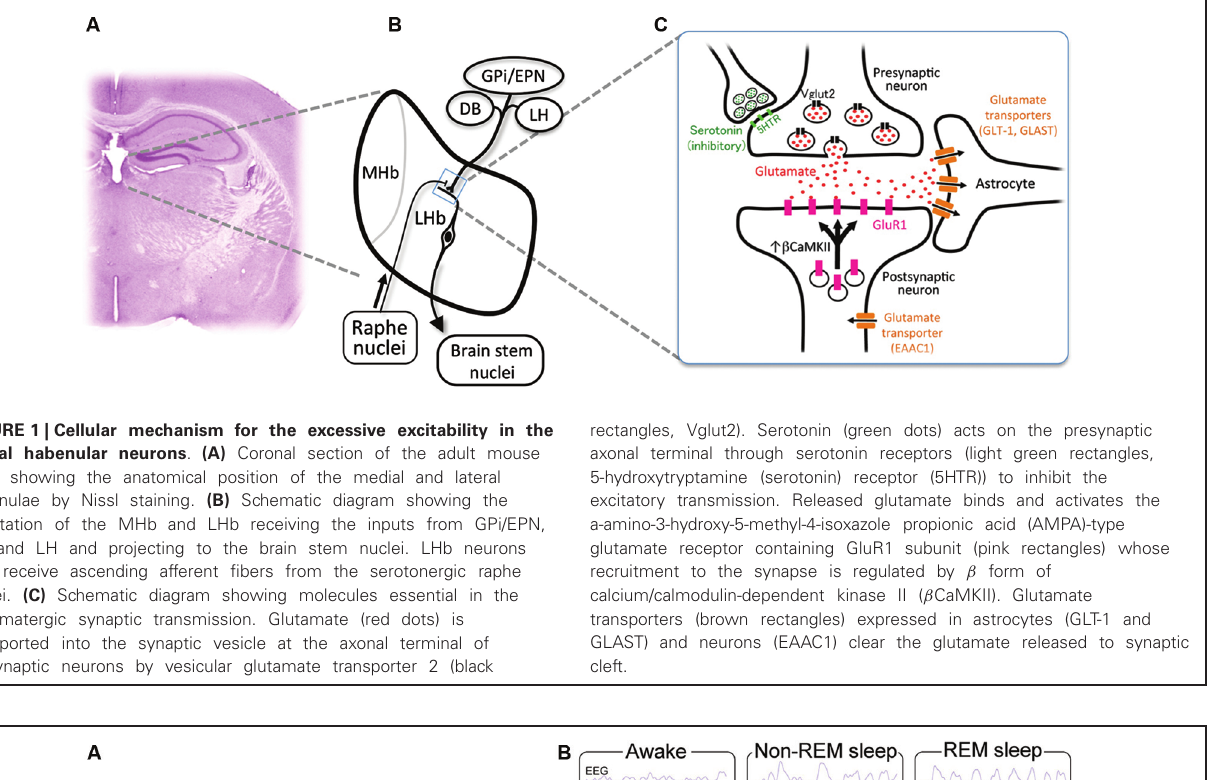
FIGURE 1 | Cellular mechanism for the excessive excitability in the lateral habenular neurons . (A) Coronal section of the adult mouse brain showing the anatomical position of the medial and lateral habenulae by Nissl staining. (B) Schematic diagram showing the orientation of the MHb and LHb receiving the inputs from GPi/EPN, DB and LH and projecting to the brain stem nuclei. LHb neurons also receive ascending afferent fibers from the serotonergic raphe nuclei. (C) Schematic diagram showing molecules essential in the glutamatergic synaptic transmission. Glutamate (red dots) is transported into the synaptic vesicle at the axonal terminal of presynaptic neurons by vesicular glutamate transporter 2 (black